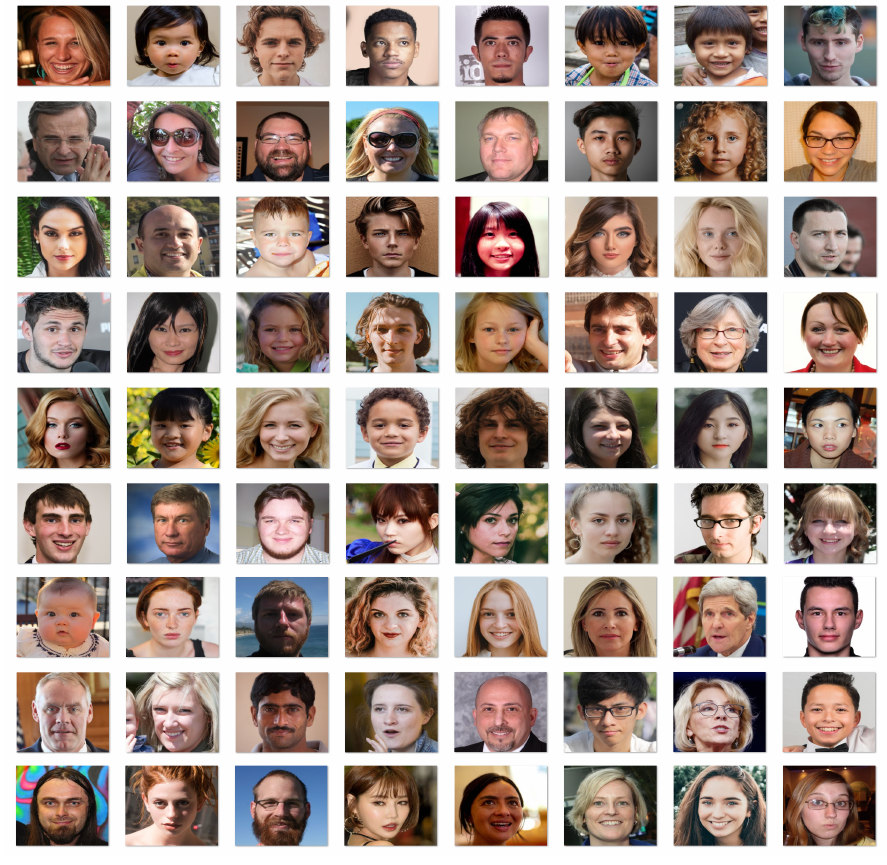
Figure 5. CelebA-HQ and FFHQ